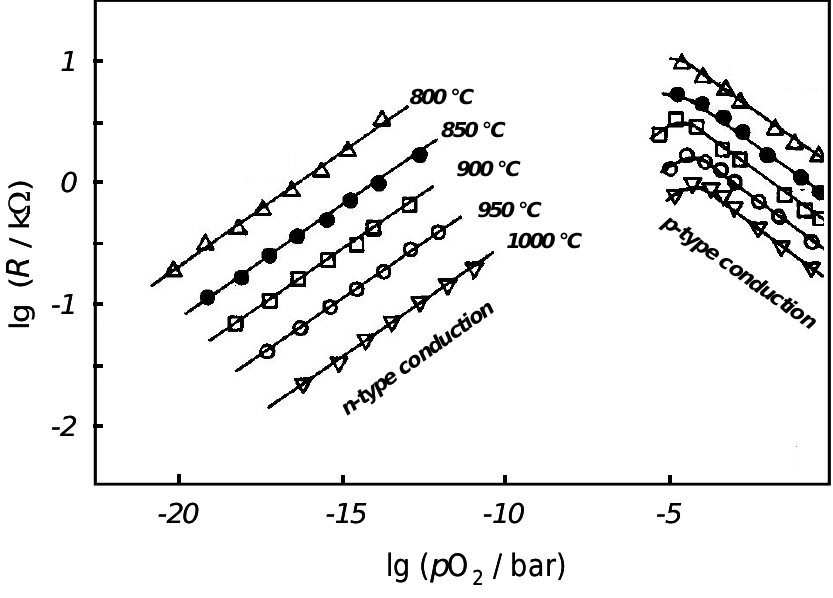
Figure 3. Typical resistance behavior of a ST thick-film sensor (here exemplarily from